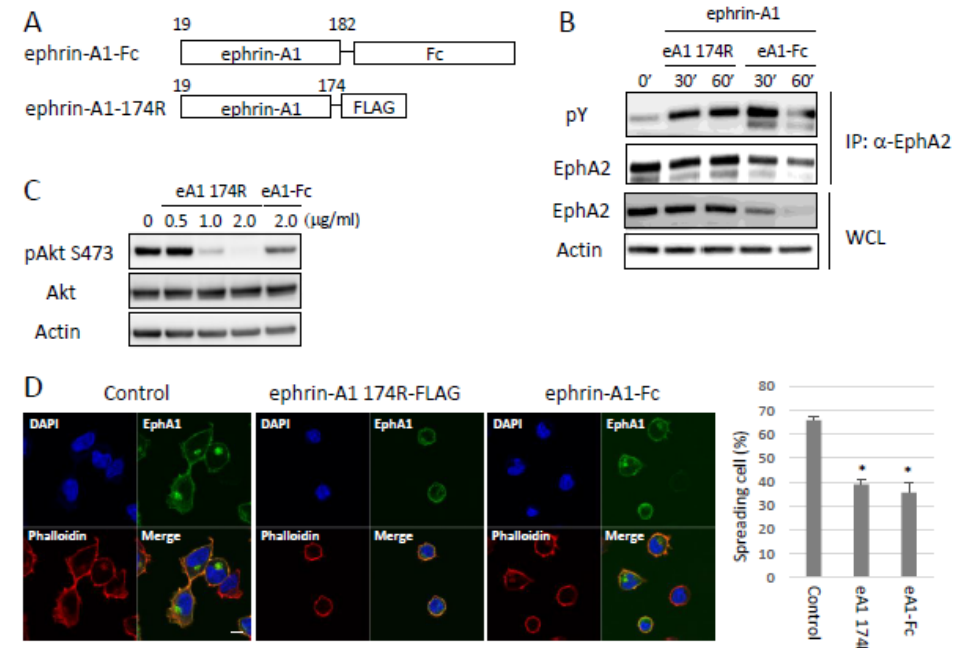
Figure 3. Bioactivity of ephrin-A1-174R. ( A ) A schematic presentation of soluble Figure 1. Fc-fused ephrin-A1 is commercially available. FLAG-tagged ephrin-A1 was produced in HEK293 cells and purified with FLAG antibody. ( B ) Tyrosine phosphorylation of EphA2. HEK293 cells expressing EphA1-EGFP were stimulated with ephrin-A1-174R for indicated time points. Ephrin-A1 174R induced tyrosine phosphorylation of EphAs, and the phosphorylation levels are comparable to those of ephrin-A1-Fc. ( C ) Dephospholylation of Akt upon ephrin-A1 stimulation. Both ephrin- A1 174R and Fc-fused ephrin-A1 induced dephosphorylation of Akt. ( D ) Cell-spreading assay on ephrin-A1-coated culture dish and the quantification. EphA1-EGFP expressing HEK293 cells were seeded onto either ephrin-A1 174R or ephrin-A1-Fc-coated well. Scale Bars: 10 μ m. Evaluation of cell-spreading defects. More than 100 cells were counted and evaluated for whether there was spread or not. Ephrin-A1 174R induced cell-spreading defects as well as ephrin-A1-Fc. (* p < 0.05).